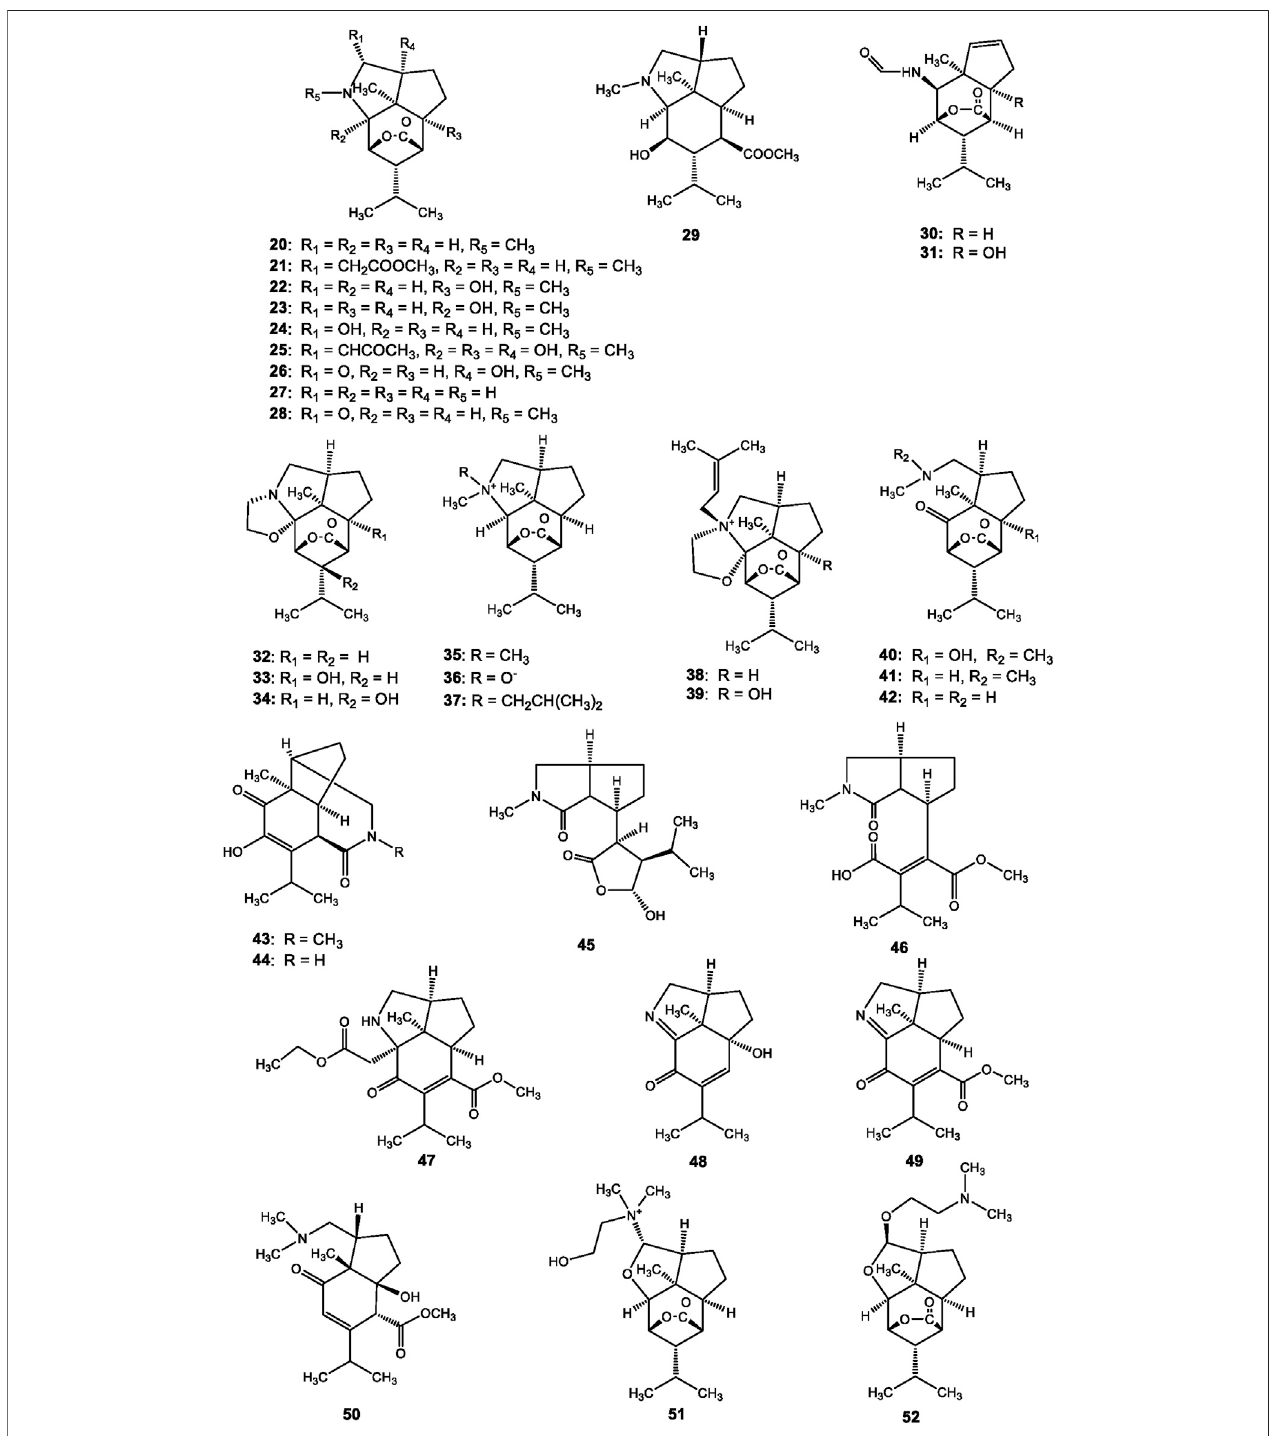
FIGURE 3 | Structures of terpenoid alkaloids reported in Dendrobium .